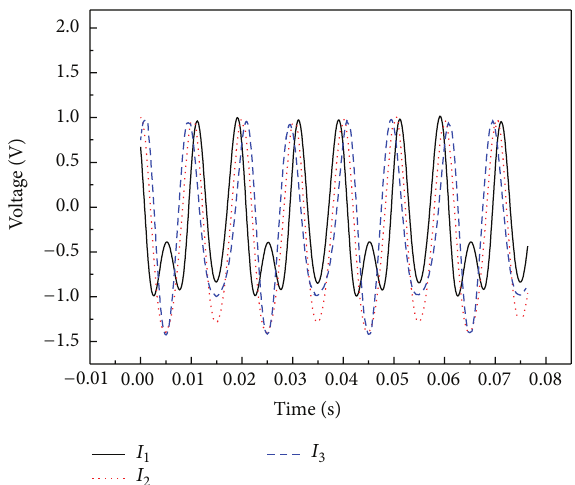
Figure 6: Two normalized sinusoidal signals and one newly gener- ated signal for the signal processing.